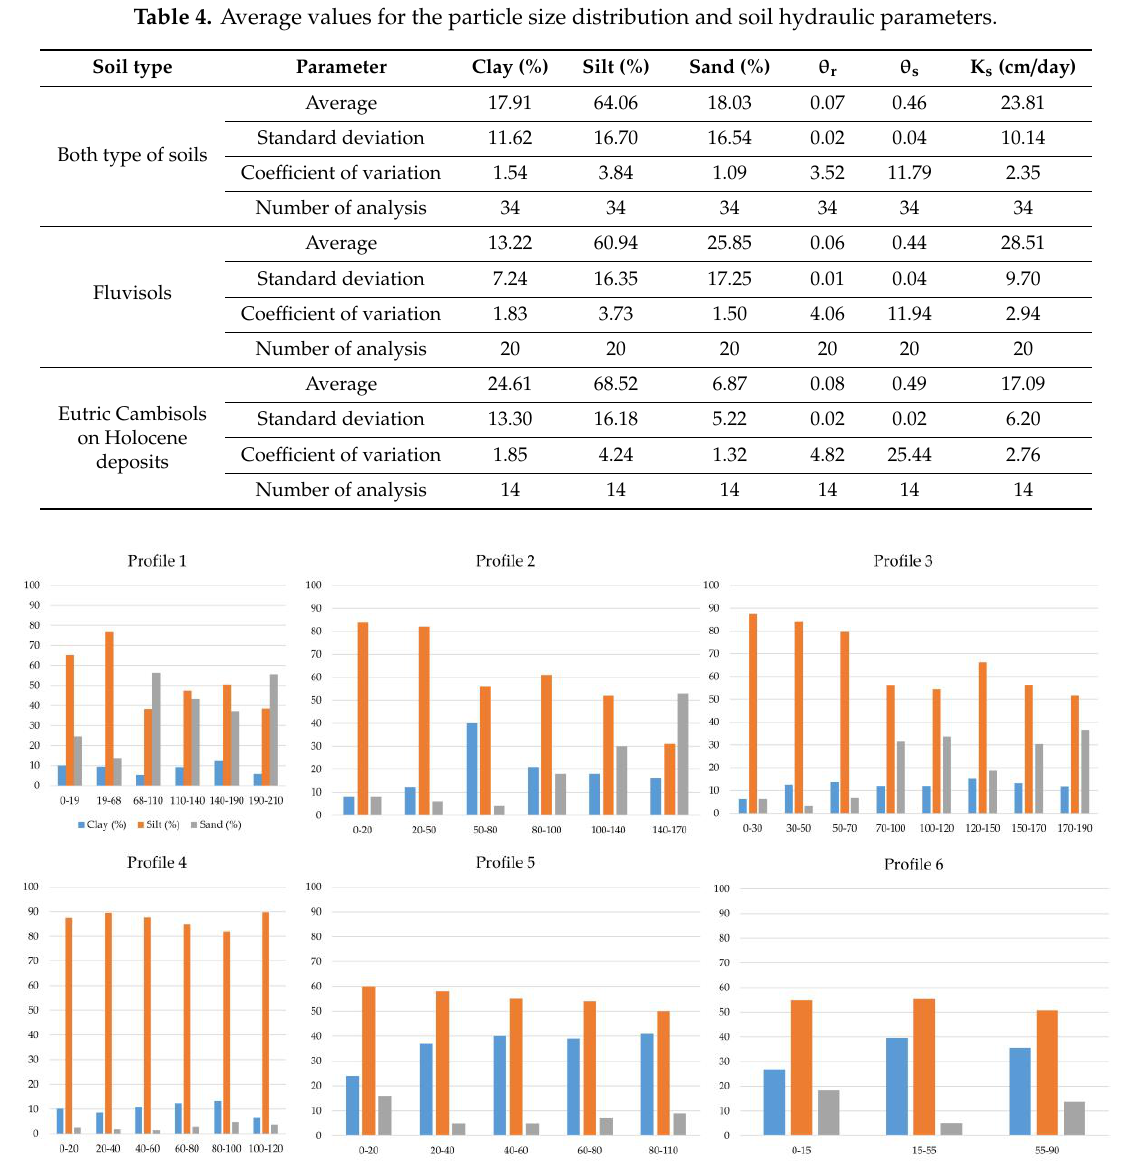
Figure 2. Particle size distribution with depth (in cm) in the six soil profiles.